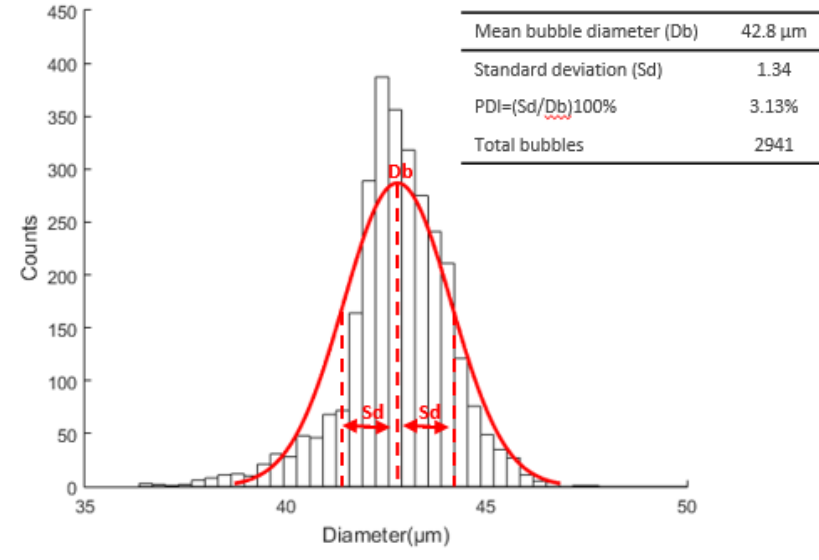
Figure 17. Microbubble diameter distribution curve with a mean diameter, standard deviation, and PDI of 42.8 μm, 1.34, and 3.13%, respectively.